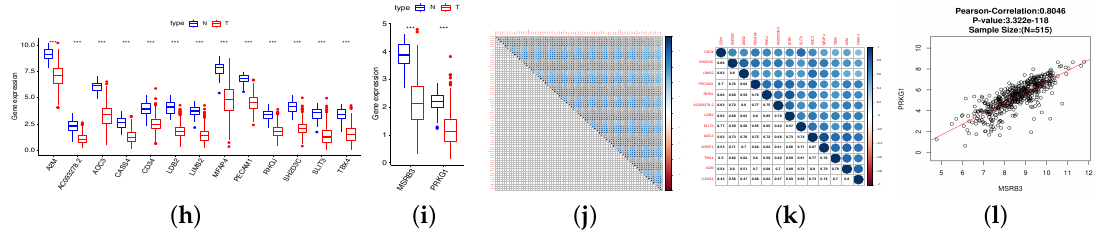
Figure 5. The selection of the key genes from the blue, brown, and purple modules. ( a – c ) The dots in the upper right quadrant of the scatter plot represent the key genes we screened. Each scatter stands for a gene, which have two score possibilities: one is its correlation with the module—the module membership (MM) score, the other is its association with the mRNAsi index—the gene significance (GS) score. The standard for screen key genes was set as both MM > 0.8 and GS > 0.5 simultaneously, which represents that this gene has both high stem cell properties and a central position in its module. The profile of key gene expression. ( d – f ) The heat-maps show the global differential expression of genes between normal and tumor cases in the LUAD dataset of TCGA in each module; green indicates downregulated genes, and red indicates upregulated genes. ( g – i ) The box-plots show that all the key genes have statistically significant differential expression between normal and tumor cases in the LUAD dataset of TCGA, specifically. The correlation among key genes of each module at the transcriptional level. ( j , k ) The upper part of the figures show the degree of positive correlation according to the color, and the lower part is the representation of the corresponding correlation value (Pearson correlation coefficient, R > 0.3). ( l ) The correlation plot of the only two genes in the purple module shows a strong correlation (Pearson correlation coefficient, R =